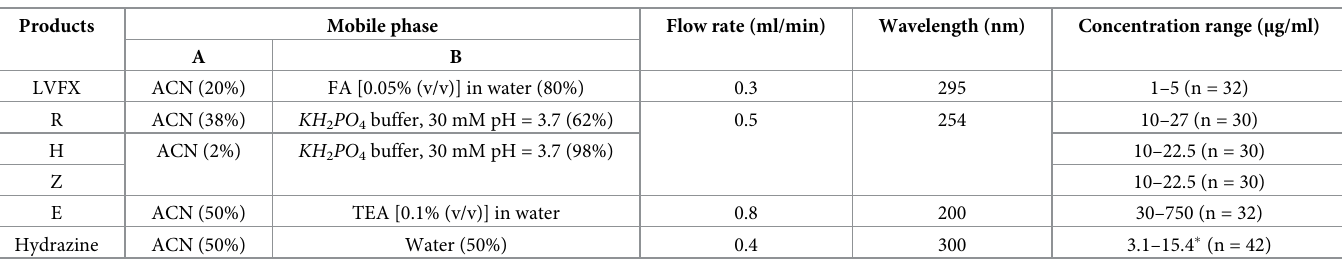
Table 1. Conditions of UPLC